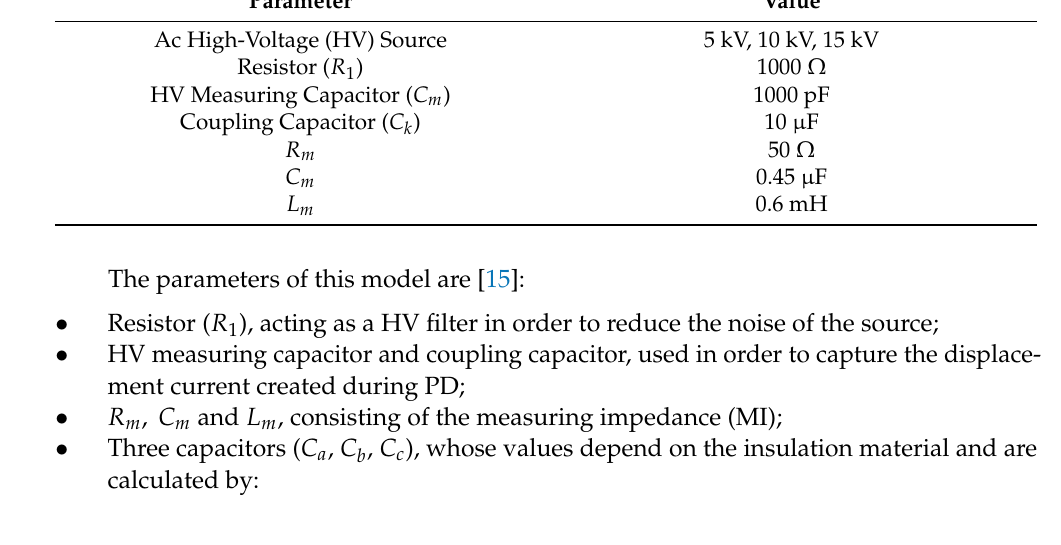
Table 3. Capacitive Model’s Parameters (h, 2 r).